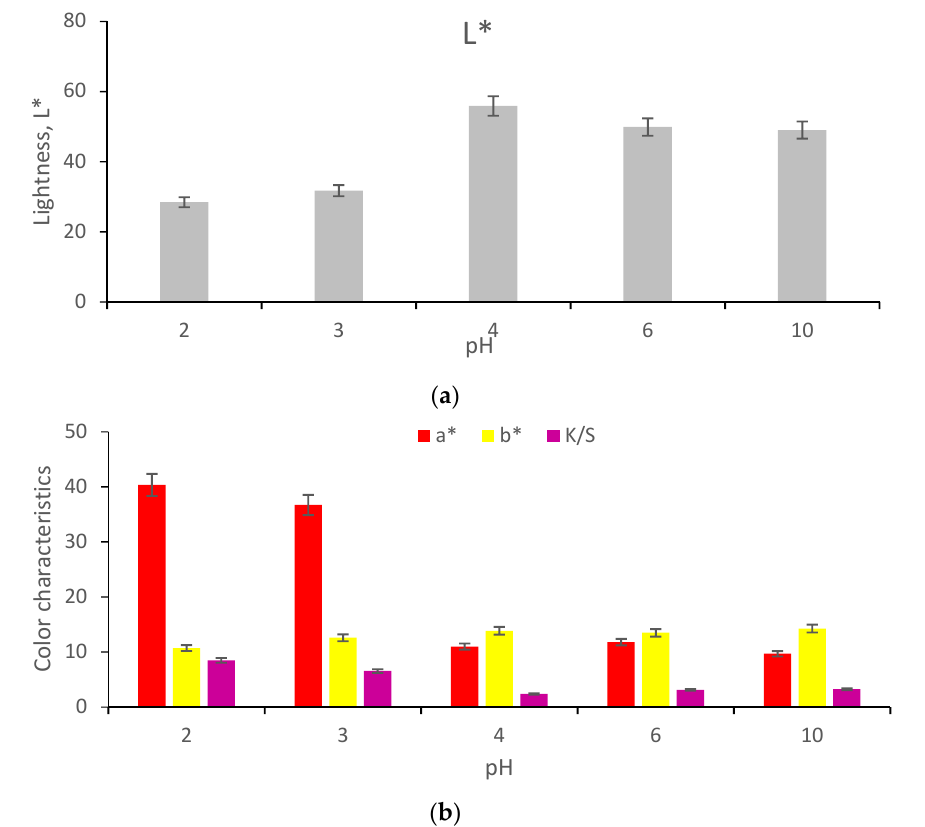
Figure 15. The influence of the pH value on the color characteristics of wool samples dyed with functionalized extract with acetic acid (for acidic pH) and with NH 3 (for basic environment): L* ( a ) and a*, b*, K/S ( b ); dyeing conditions: T = 40 °C, t = 2 h, V = 100 mL, M = 1: 100. The color variations are generated by the changing ratios of betaxanthin and beta- cyanin content [34]. The color of the dyed wool samples varies depending on the pH of the dyeing medium, as follows: red-dark at pH ≤ 2, strong red at pH = 3, bright-red at pH 4, and very slow red as the pH = 6.